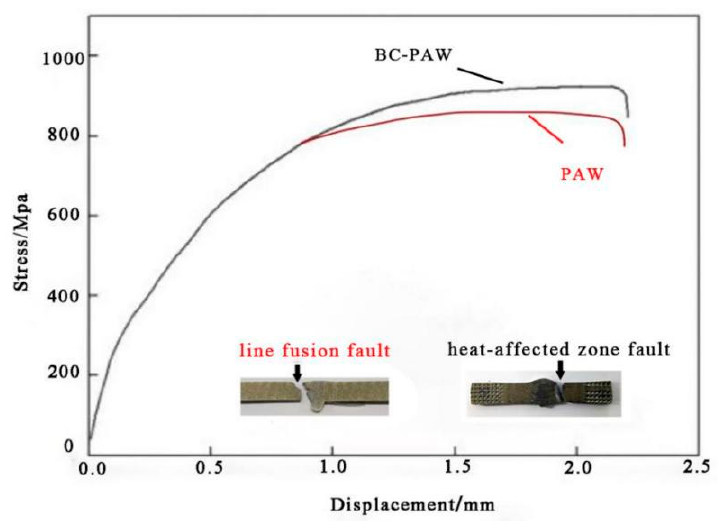
Figure 10. Stretch stress–displacement curve through bypass current hot wire plasma arc welding compared with the traditional method.